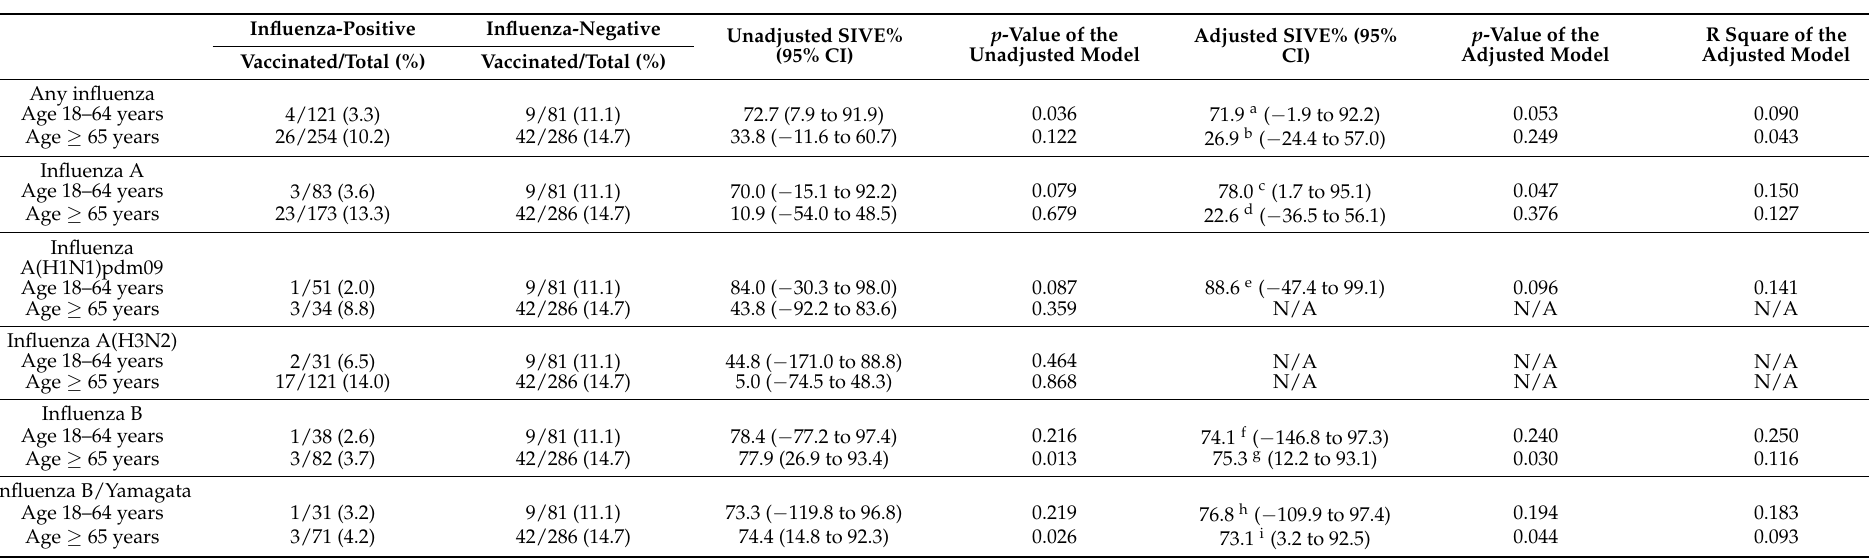
Table 4. Seasonal influenza vaccine effectiveness against different laboratory-confirmed influenza subtypes by age groups during the 2015–2019 influenza seasons. Influenza-Positive Influenza-Negative Unadjusted SIVE%